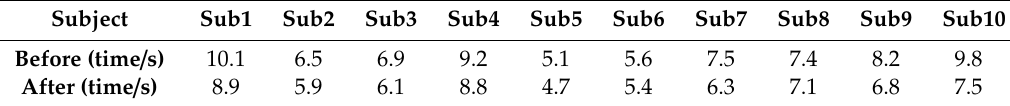
Table 11. Changes of the average transfer time.